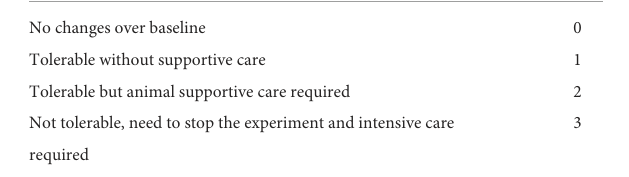
TABLE 1 Criteria for macropathologic scoring of RIOM.